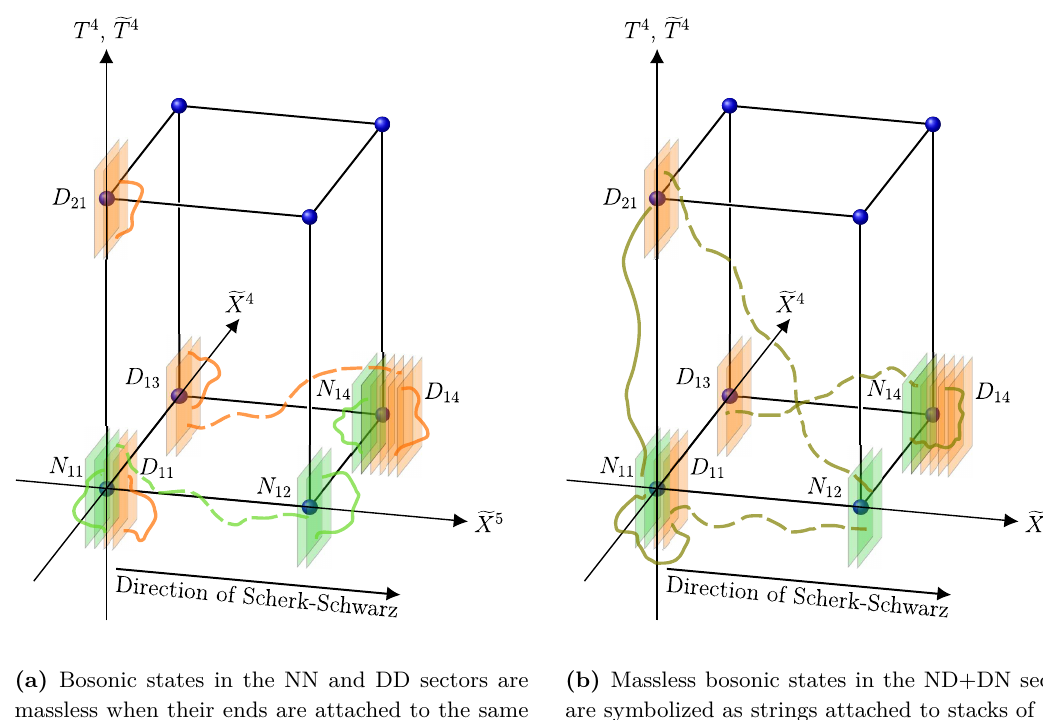
(a) Bosonic states in the NN and DD sectors are massless when their ends are attached to the same stack of branes. By contrast, fermionic states in the NN and DD sectors are massless when they are real- ized as strings stretched between corners of the six- dimensional boxes that are facing each other along the T-dual Scherk-Schwarz direction. Figure 2. Visualization of the massless open-string states in the D3-brane pictures. The scalars are depicted as solid lines and the fermions as dashed